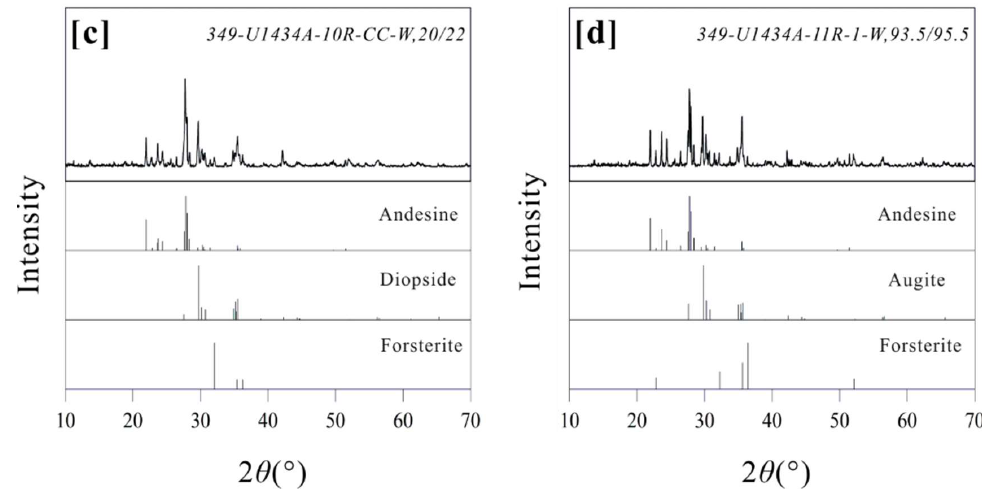
Figure 4. X-ray diffraction patterns of the representative basaltic samples of Sites U1433 and U1434.